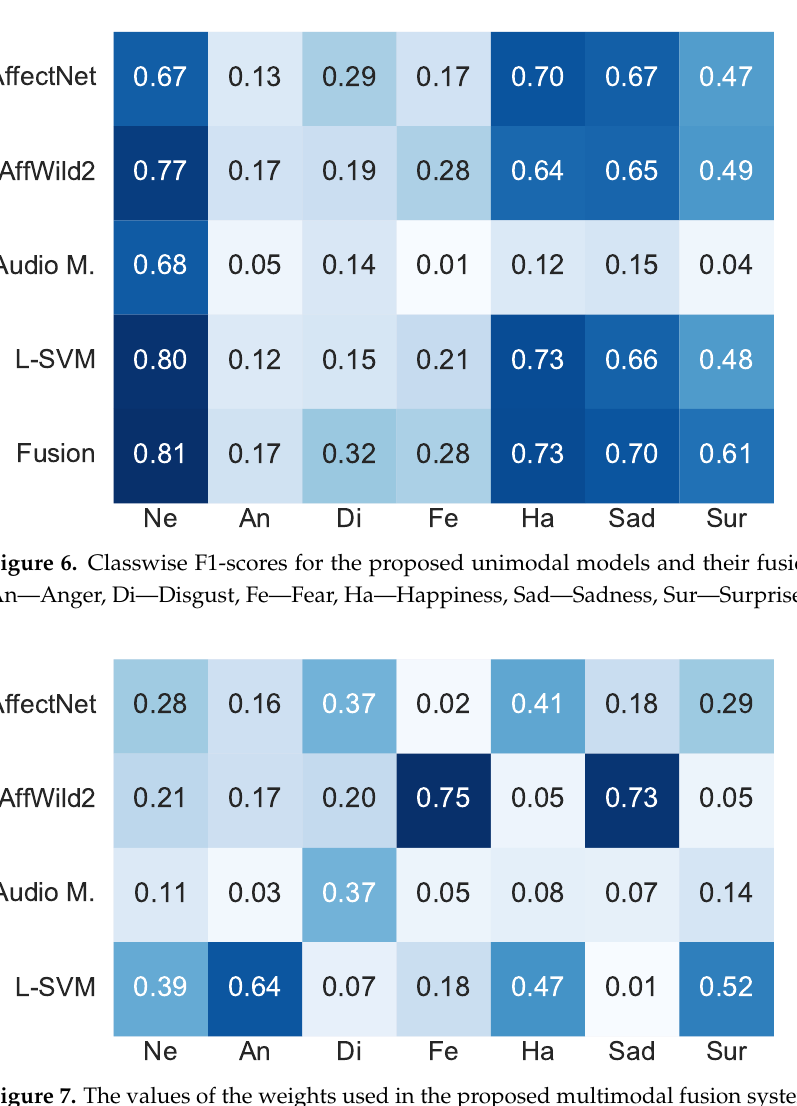
Figure 7. The values of the weights used in the proposed multimodal fusion